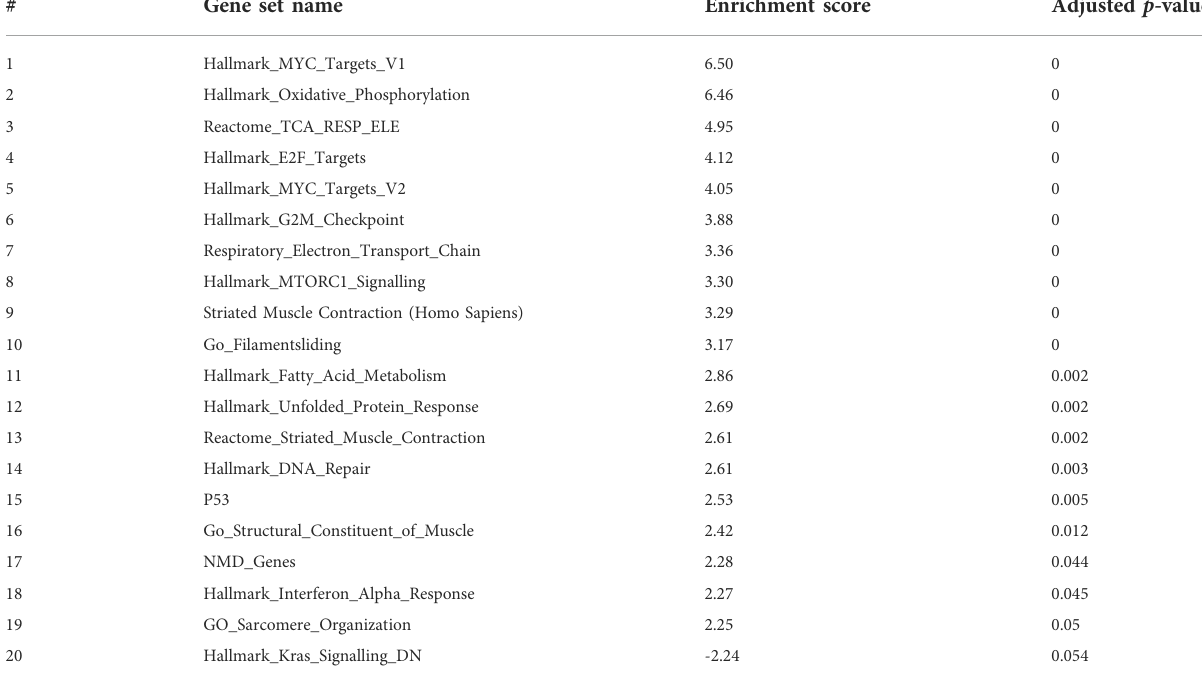
TABLE 5 Gene Set Enrichment Analysis (GSEA) of gne KO versus gne WT zebra fi sh at 5